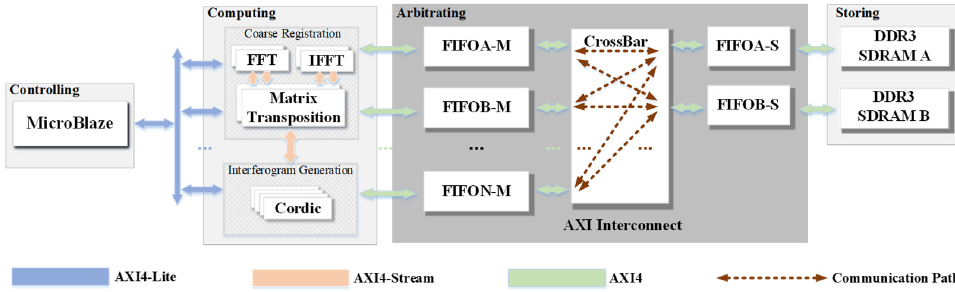
Figure 2. The architecture of the system. In “FIFOA-M” and “FIFOA-S”, “FIFO” means “First In First Out”, “N” is the number of FIFO, “M” and “S” denotes Master and Slave respectively. “DDR” represents “Double Data Rate”.